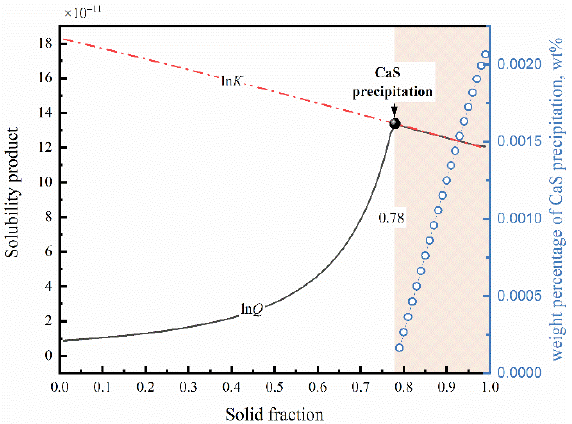
Figure 4. Effect of cooling rate on ( a ) S and ( b ) Ca content in the residual liquid.